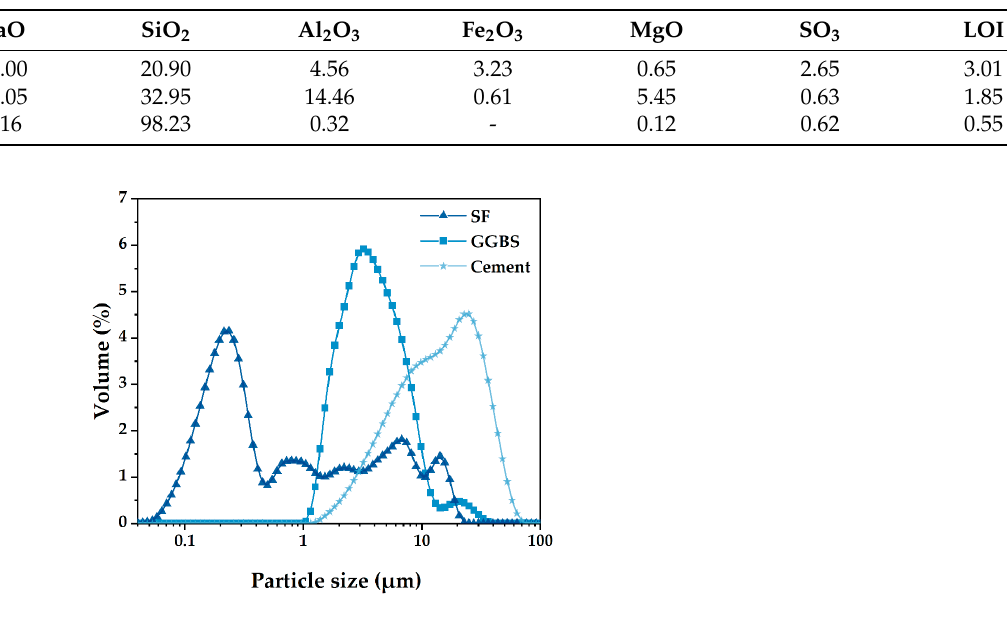
Figure 3. Particle size distribution of cement, slag and